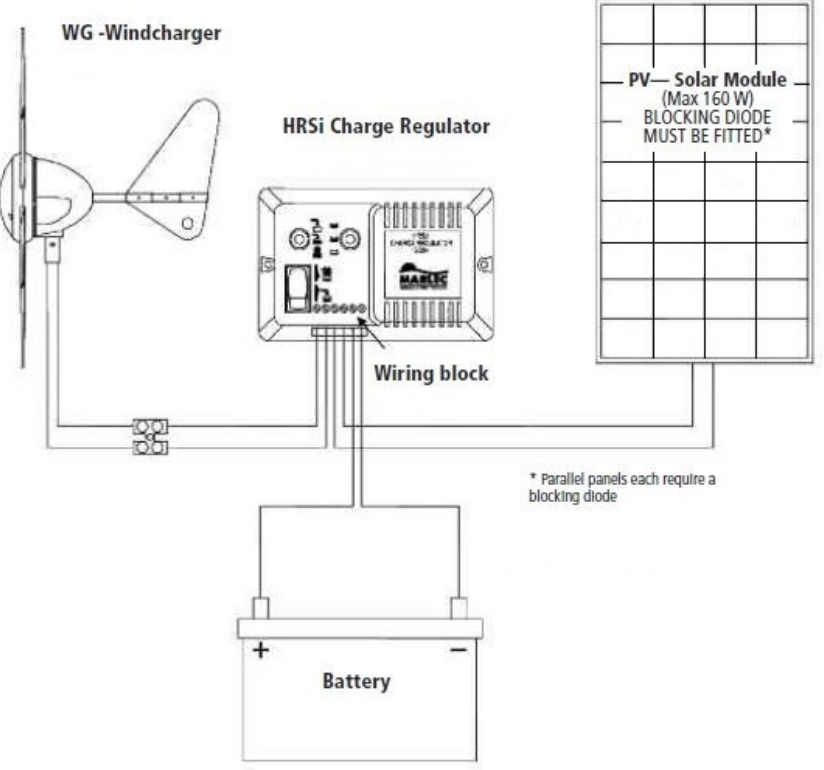
Figure 2. Connection scheme of the station power supply system.